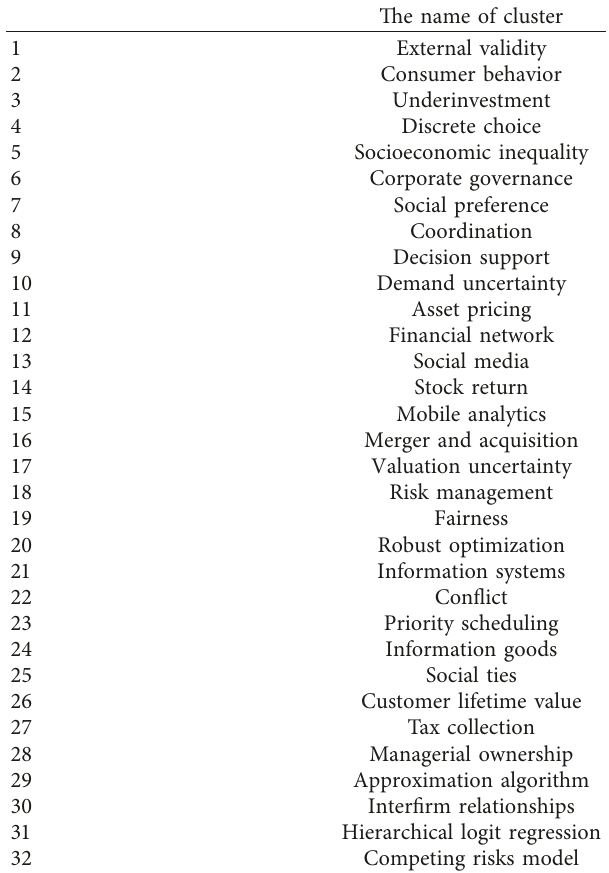
Table 11: The number and name of the